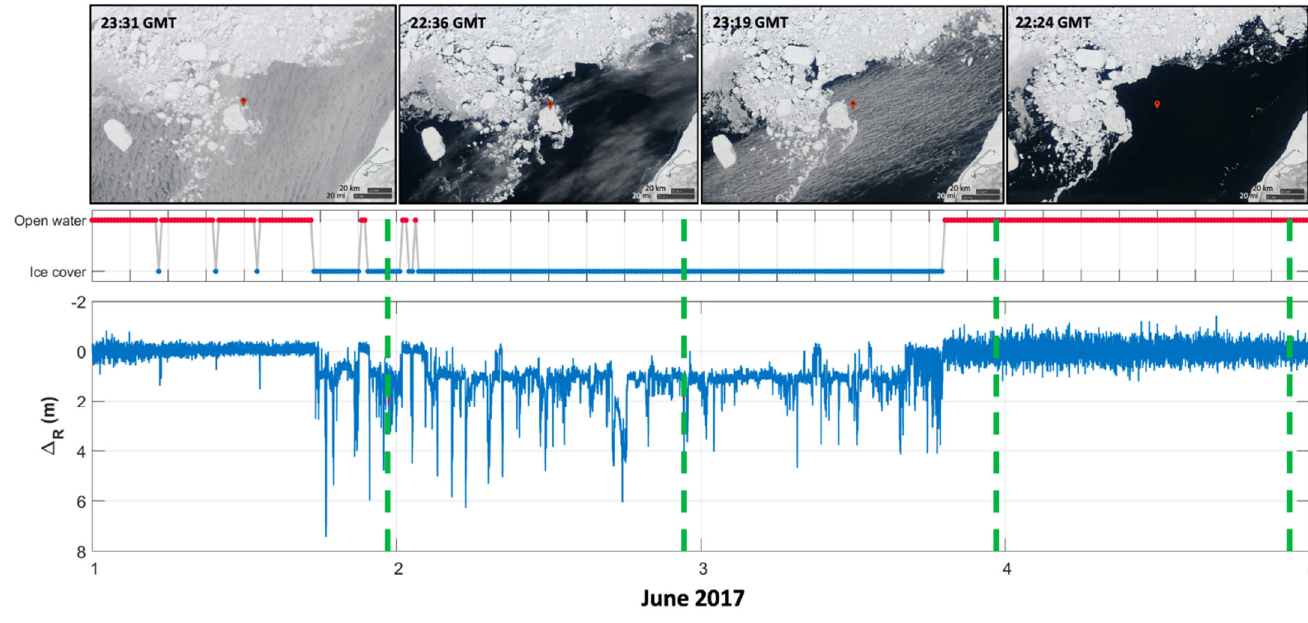
Figure 13. Time series documenting the passage of a large ice floe over the CEO mooring on 1–4 June 2017. The lower panel shows the ∆ R estimates for the four days, the middle panel contains the SOM BMU for the same timeframe, and the upper panels show one true color Terra/MODIS satellite images for each day. The red marker in the satellite images shows the location of the CEO site in the NE Chukchi Sea, and the dashed green line shows the approximate time of each day in which the images were captured.